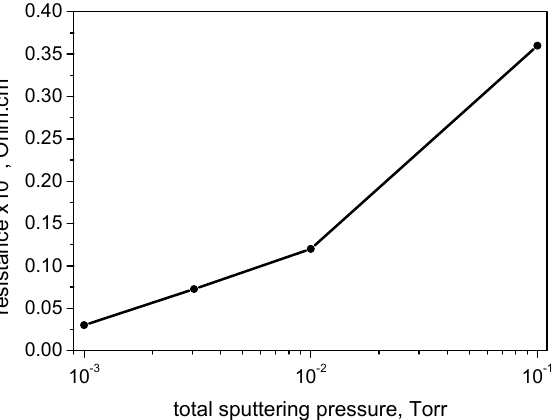
Figure 2. Electrical resistance of the bi-layer system ITO/GZO at different total sputtering pressures due to additional target oxidation [31].